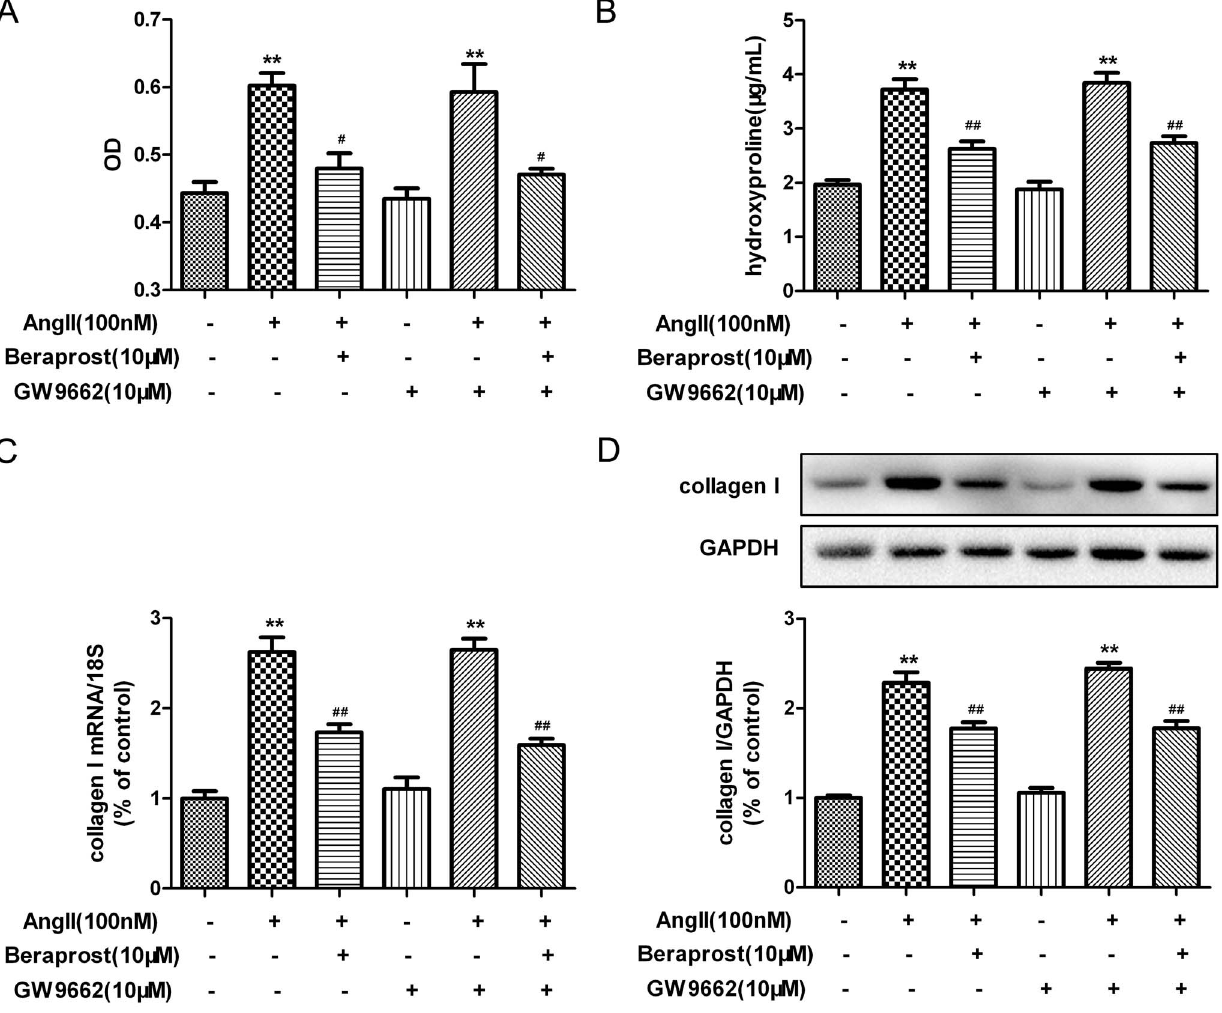
Figure 4. Peroxisome proliferators-activated receptor c (PPAR c ) is not involved in attenuating effect of beraprost on Ang II-induced cardiac fibroblast proliferation and collagen I synthesis. Neonatal rat cardiac fibroblasts were serum deprived for 24 h and pre-treated with specific PPAR c antagonist GW9662 (10 m M) for 4 h. Cells were then incubated with beraprost (10 m M) for 4 h followed by Ang II (100 nM) stimulation for an additional 24 h. (A) The number of cells was represented as an OD value using a cell count assay. (B) Content of hydroxyproline in cell culture medium was determined. (C) Collagen I mRNA expression was assessed by real time PCR. (D) Cell lysates were tested for collagen I protein expression by western blot. Values are expressed as mean 6 SEM. Cells without Ang II and beraprost stimulation served as a control (con). ** P , 0.01, compared with con, # P , 0.05, ## P , 0.01 compared with Ang II stimulated group following with or without GW9662 pre-treatment. n=4–6.